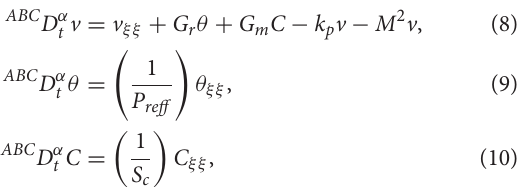
Frontiers in Physics |